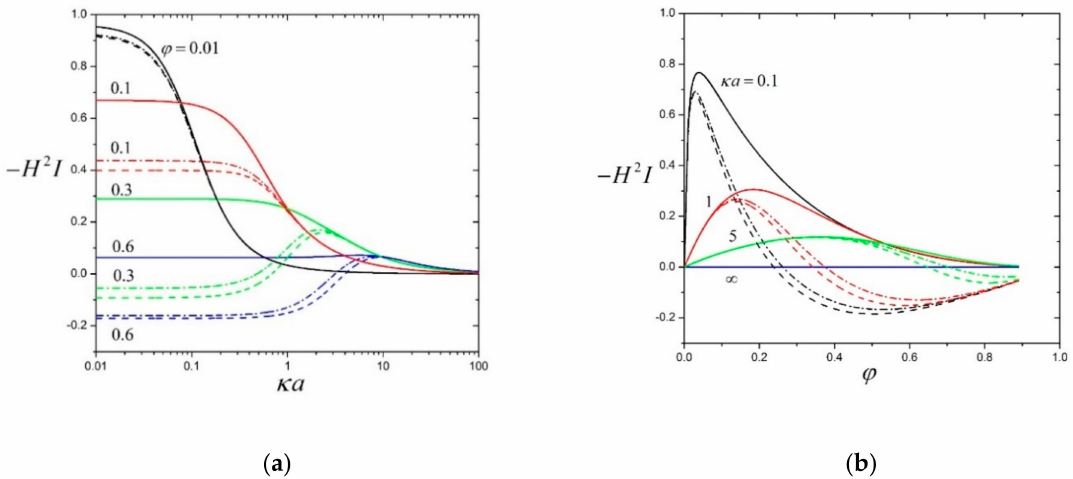
Figure 7. The dimensionless coefficient H 2 I in Equation (29a) for the Levine-Neale cell model for the effective electric conductivity in a fibrous medium calculated from Equations (31) and (32) versus the parameters κ a ( a ) and ϕ ( b ). The solid, dot-dash, and dashed curves represent the cases of the charge regulation parameter La equal to 0, 5, and ∞ ,